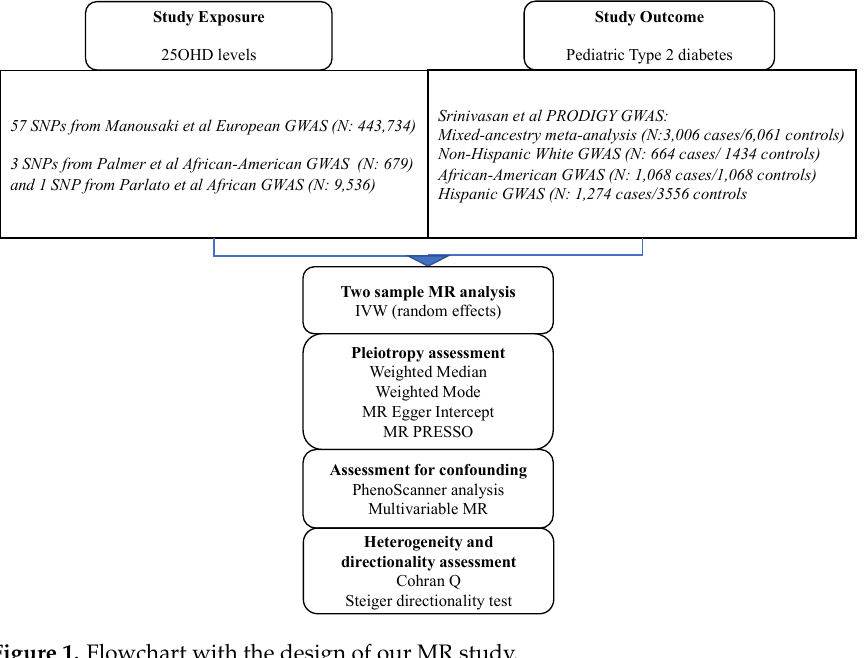
Figure 1. Flowchart with the design of our MR study.